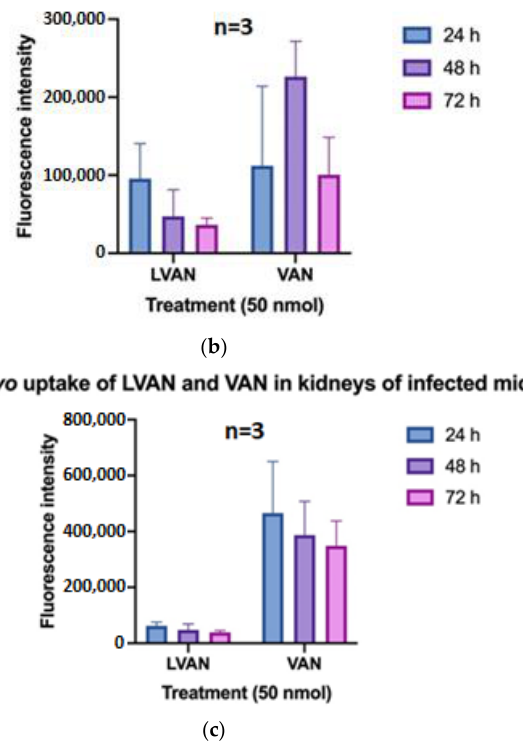
Figure 6. ( a ) The in vivo uptake of LVAn and VAN in MRSA infected mice thigh tissue is shown. Significant accumulation of LVAN over time, post-injection, as compared to VAN in MRSA-infected thigh tissue in mice model is shown. A signif- icant improvement in the localization and retention of LVAN compared to VAN is seen at the infected thigh tissues. ( b ) The in vivo uptake of LVAn and VAN in liver of MRSA infected mice is shown. Compared to LVAN, VAN was retained in the liver for a longer time, with a significant accumulation of VAN at 48 h post-injection. The data reveal a promising safety profile of LVAN for further development. ( c ) The in vivo uptake of LVAn and VAN in kidneys of MRSA infected mice is shown. An insignificant accumulation of LVAN in the kidneys compared to VAN was seen at all time points studied, strengthening the idea of non-toxic delivery of the antibiotic via the liposomal delivery